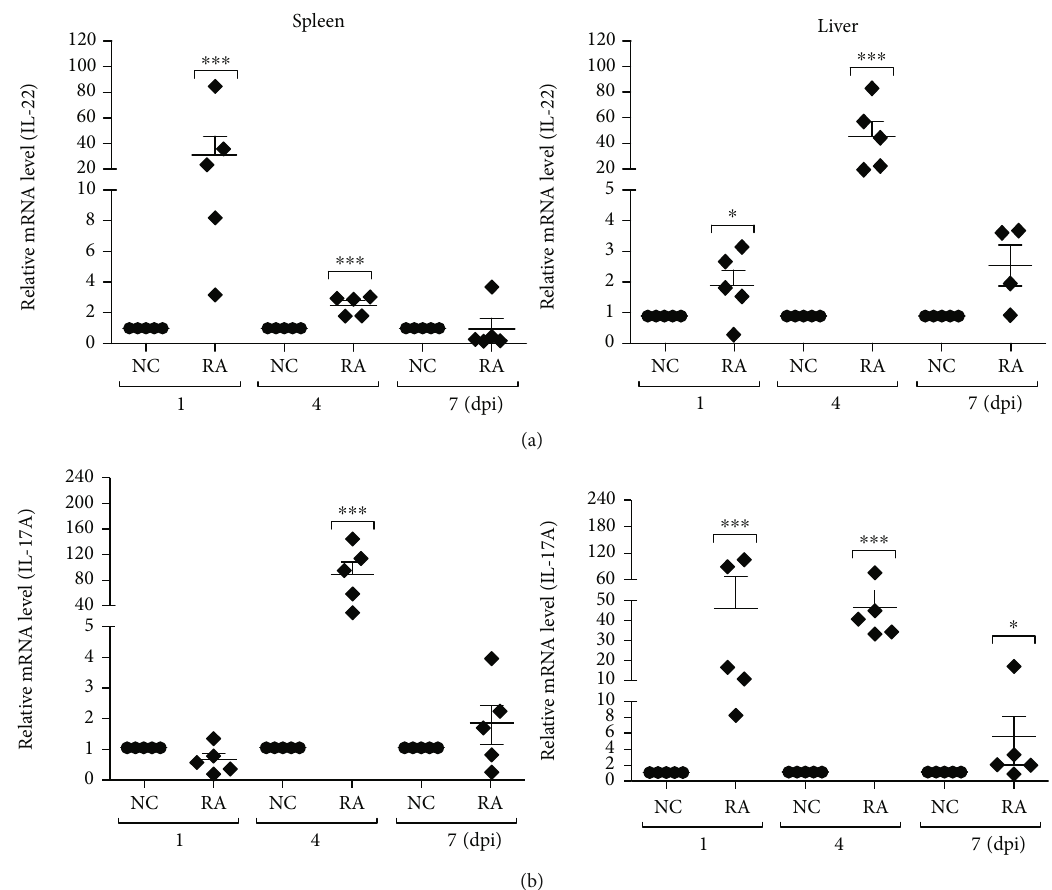
Figure 4: Expression pro fi les of IL-22 in ducks infected with R. anatipestifer . Expression levels of IL-22 (a) and IL-17A (b) transcripts from the spleens and livers of ducks infected intramuscularly with 5 × 10 7 CFUs of R. anatipestifer serotype 7. The spleens and livers of 2-week- old healthy ducks were aseptically sampled on days 1, 4, and 7 postinfection (dpi). Tissue samples were pooled, and total RNA was isolated for qRT-PCR. Gene expression levels were normalized with β -actin used as a reference gene and presented relative to the expression levels of uninfected and healthy controls (NC). These results represented one representative of 2 independent experiments. Results are presented as the mean ± SE values ( n = 5 ). ∗ P < 0 : 05 and ∗∗∗ P < 0 : 001 . dpi: days postinfection; RA: R. anatipestifer -infected